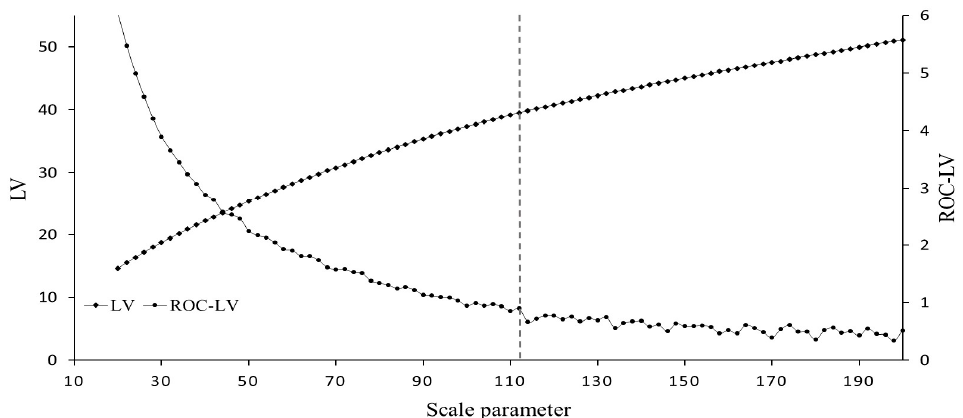
Figure 5. Scatter diagrams produced by the Estimation of Scale Parameter (ESP) 2 tool. The local variance (LV) and the rate of change of LV (ROC-LV) values are plotted against corresponding scale parameters. The gray vertical dotted line shows our selected optimal SP. Table 1. Object features used for image analysis with the object-based SVM method. GLCM: gray- level co-occurrence matrix. GLDV: gray-level difference vector.